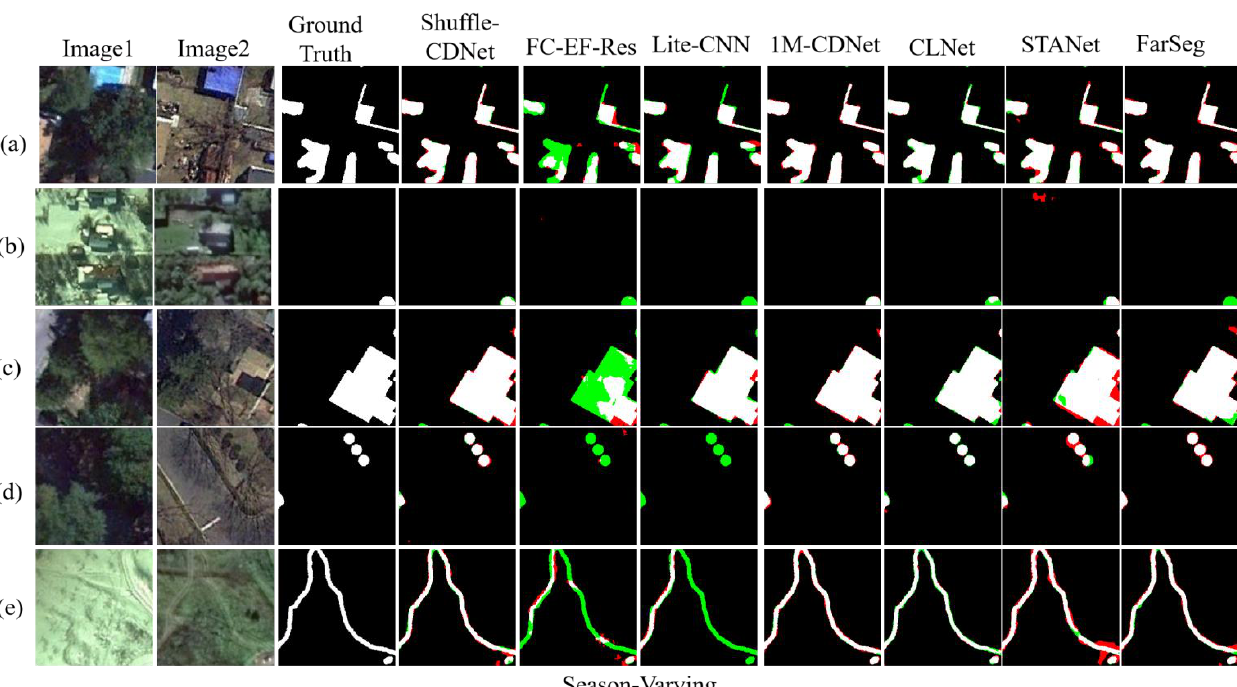
Figure 6. Results on the season-varying test sets. Different colors are used for a better view, i.e., white for true positive, black for true negative, red for false positive, and green for false negative. ( a – e ) are results of five pairs of bitemporal images.